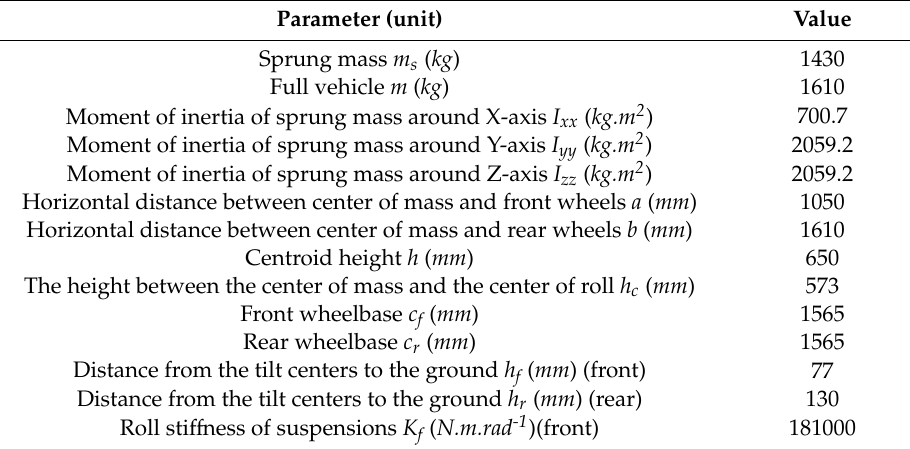
Horizontal distance between center of mass and front wheels a ( mm ) Horizontal distance between center of mass and rear wheels b ( mm